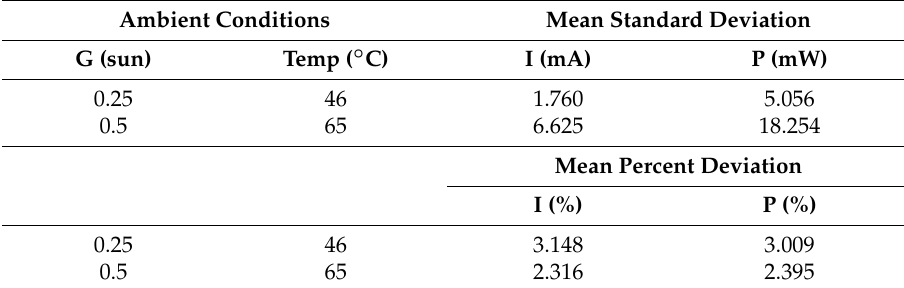
Table 3. Comparison between simulation and test results values at different ambient conditions. conditions.